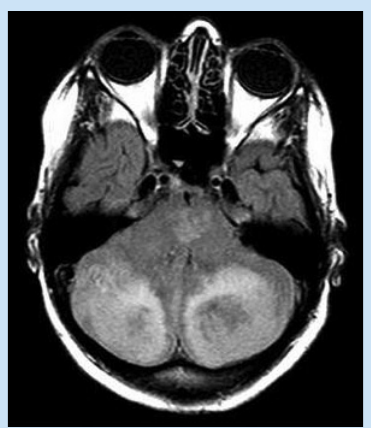
Fig. 2a. 30-year-old woman who developed HELLP syndrome and eclampsia shortly after delivery at 39 weeks. This FLAIR MR image shows areas of increased signal in the cere- bellum and